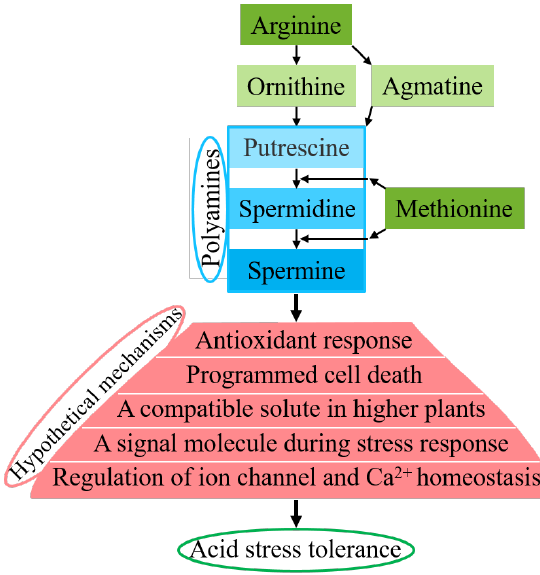
Figure 9. Overview of hypothetical regulatory mechanisms of enhanced acid stress tolerance via polyamines. Acid stress induces the accumulation of polyamines, which then function in antioxidant responses, in programmed cell death, as compatible solutes in higher plants, as signaling molecules during stress responses, in the regulation of ion channels and Ca 2+ homeostasis, and in other unknown pathways, by scavenging excess free radicals or stabilizing membranes by binding to negatively charged groups, leading to enhanced acid stress tolerance.